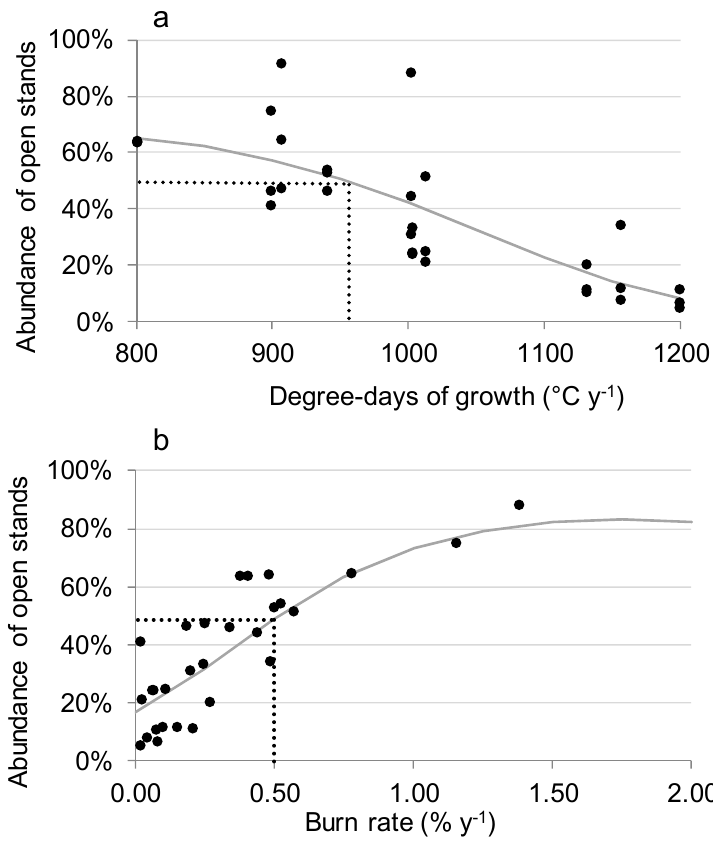
Figure 5. Relationship between the abundance of open stands by fire zone and degree ‐ days of growth ( a ) and burn rate ( b ). Continuous lines refer to the logistic regression presented in Table 2.